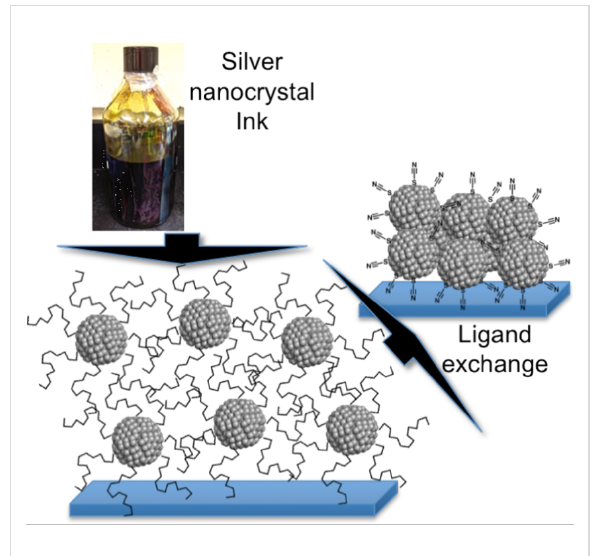
Figure 4: Post-deposition liquid exchange increases conductivity by replacing the insulating oleylamine ligand shell with ammonium thio- cyanate. Reprinted with permission from [30], copyright 2014 Amer- ican Chemical Society.